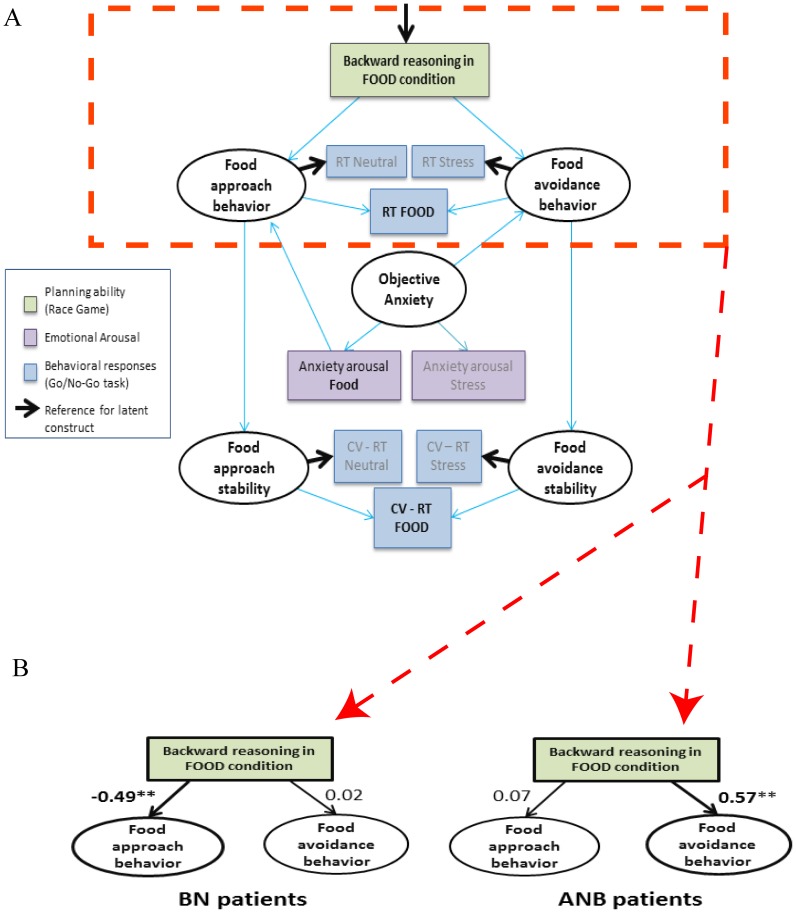
Model used to investigate the association between backward reasoning in the Race Game in the food condition and approach or avoidance behaviors, under the influence of anxiety (Figure A).Food approach behavior was determined by the shared variance of the reaction time (RT) at correct Go trials between food and neutral/relaxing conditions with neutral/relaxing data as a reference. Food avoidance behavior was determined in a similar manner, using the stressful and food conditions. Similar reasoning was carried out for “food specific” anxiety arousal and coefficient of variation of reaction time (CV-RT). Bold arrows represent reference loadings for latent variables (ellipses) and have a factor loading set to 1. Standardized coefficients are reported for Bulimia Nervosa (BN) and Anorexia Nervosa Binging subtype (ANB) patients (Figure B and supplementary table ST4 in file S2). **: p<0.05.